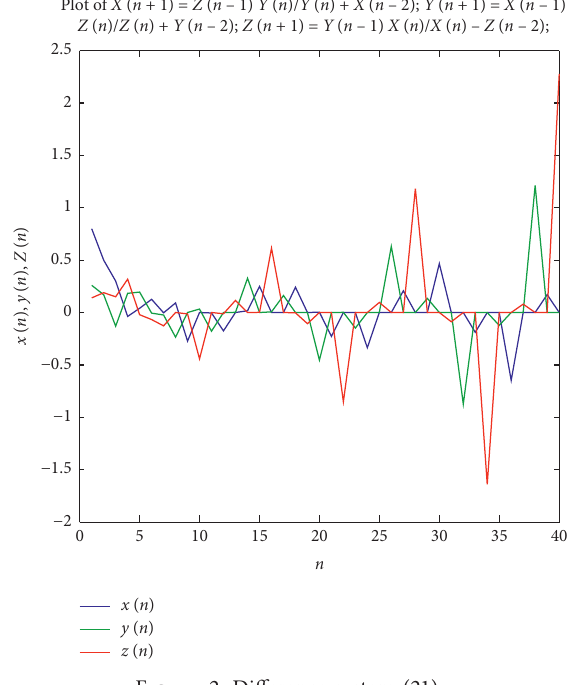
Figure 2: Difference system